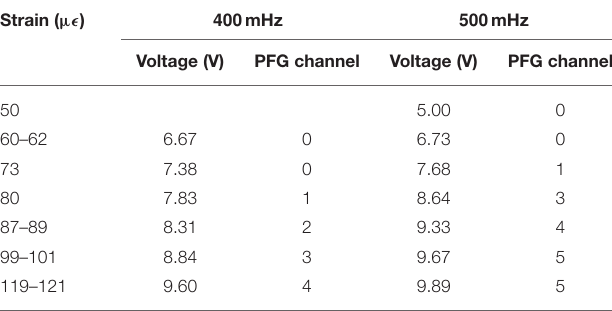
TABLE 1 | Measured PZT strain-voltage and PFG activation vs. frequency.